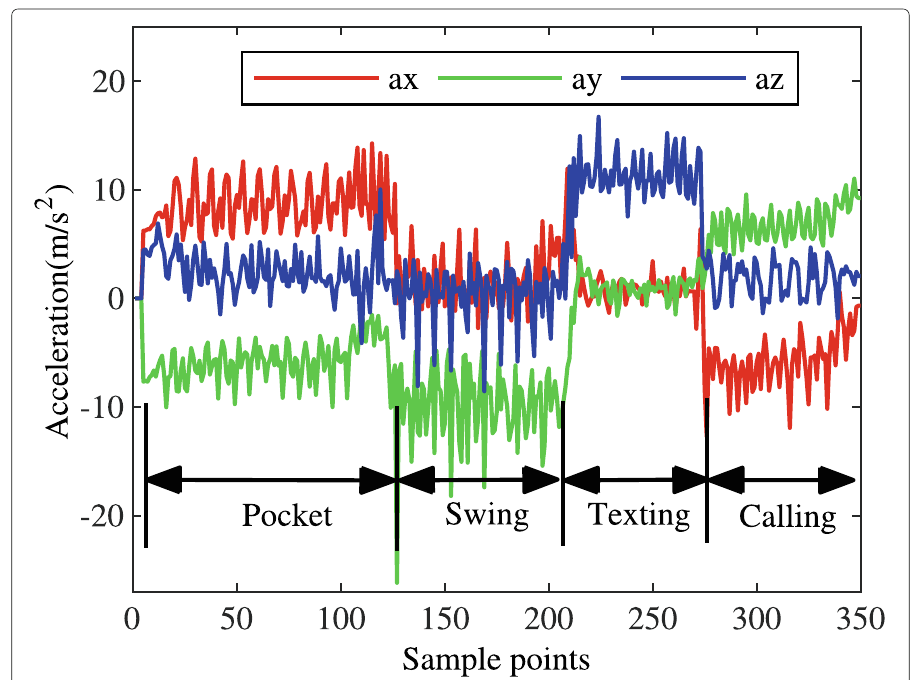
Fig. 1 Triaxial acceleration curves of different mobile phone usage modes